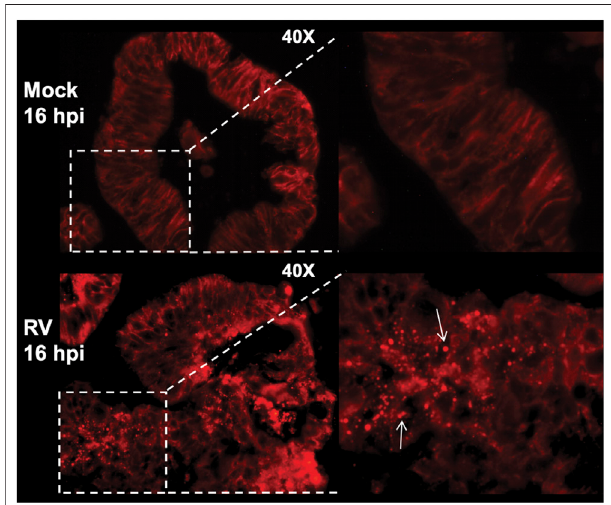
FIGURE 4 | RV-infection of human intestinal enteroids induces lipid droplets. Human jejunal enteroids were metabolically labeled with fl uorescently-tagged BODIPY-fatty acid for 1 h prior to mock or RV infection. Enteroids imaged by epi fl uorescence at 16 hpi show BODIPY-fatty acid is retained in the endoplasmic reticulum lipid bilayer of mock-infected enteroids (top panel). In contrast, RV infection induces lipid droplet formation indicated by the round, red lipid droplets (bottom panel, arrows). The inset on the right is a magni fi cation of the boxed area. [From Foulke-Abel et al., 2014 (Foulke-Abel et al., 2014)].